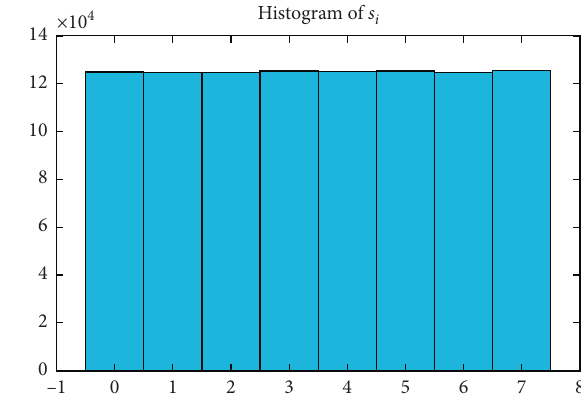
Figure 11: Power spectrum (FFT) of the product signal x with a � 1.4, b � 3, c � 1.4, and d � 0.85.